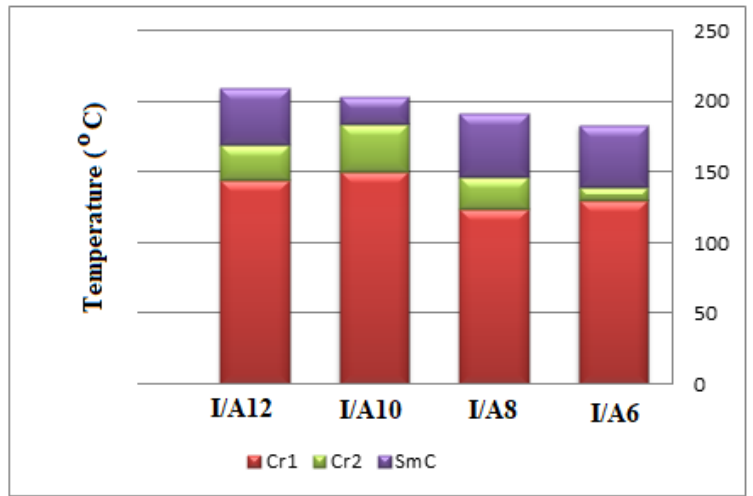
Figure 6. Graphical DSC transitions of 2:1 SMHB complexes, I / An .